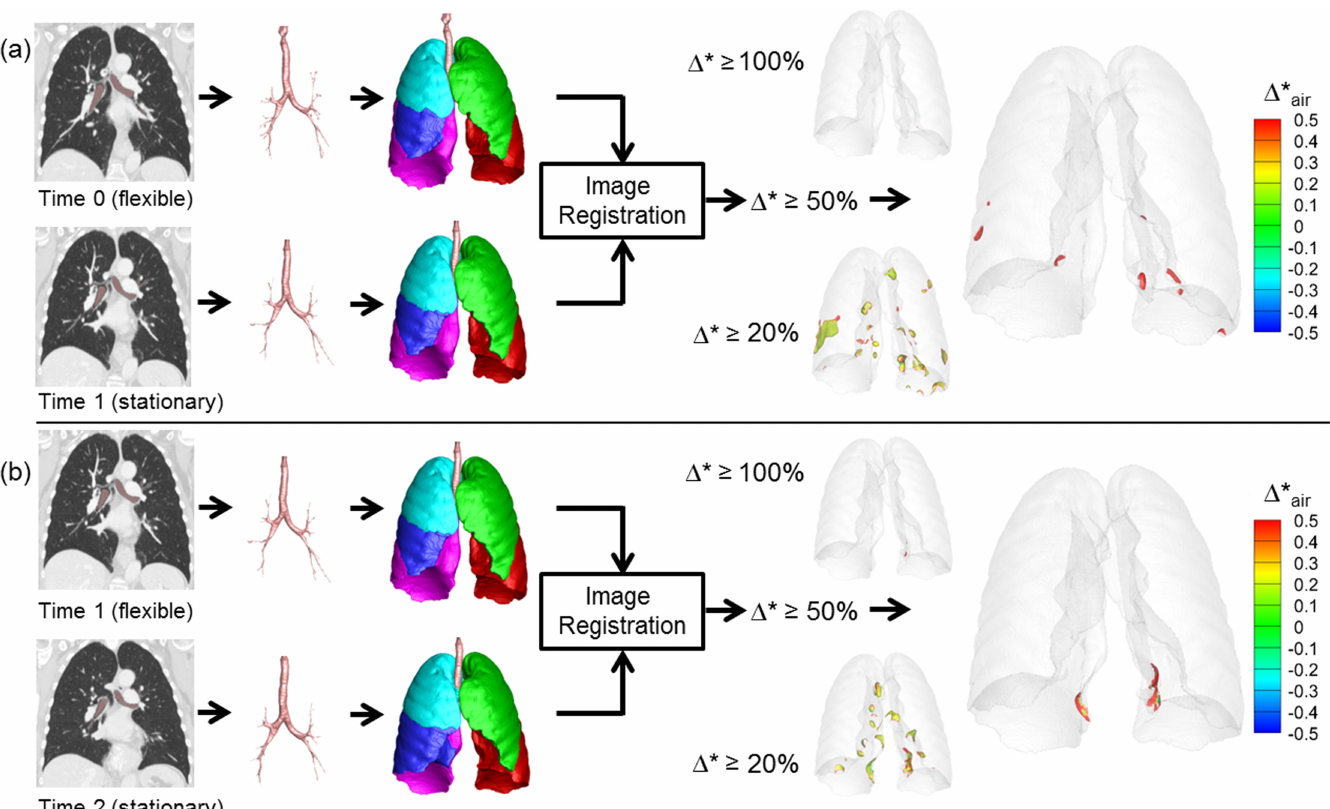
Fig 5. Regional hyper-expansion signals in serial CT pairs of a sarcomapatient (Group 3) with no lung metastasisand no therapy or resection. (a) Time 0 to Time 1 and (b) Time 1 to Time 2. Lung metastases were not found at any of three time points, Time 0, Time 1 and Time 2.